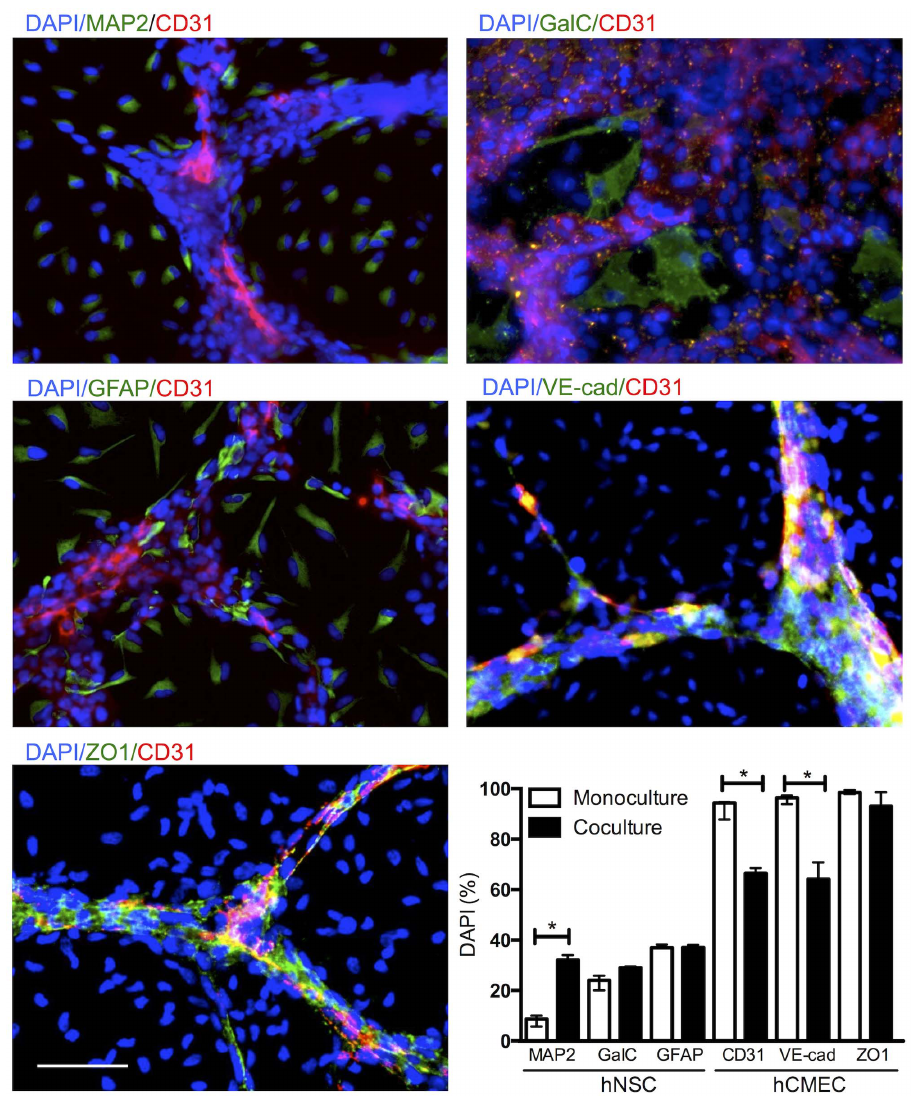
Figure 11. Differentiation status in hCMEC/hNSC coculture. To determine the phenotypic effects of the coculture of hCMECs with hNSCs, specific markers relevant to the differentiation of hNSCs into neurons (MAP2 + ), astrocytes (monoclonal GFAP + ) and oligodendrocytes (GalC + ), as well as junction proteins in hCMECs (CD31, VE-cadherin, ZO1) were measured. There was a 3-fold increase in neuronal differentiation in coculture versus monoculture, but no significant effect on astrocytic or oligodendrocyte differentiation. Apart of ZO1, the percentage of hCMECs expressing CD31 and VE-cadherin was significantly reduced in coculture with hNSCs.